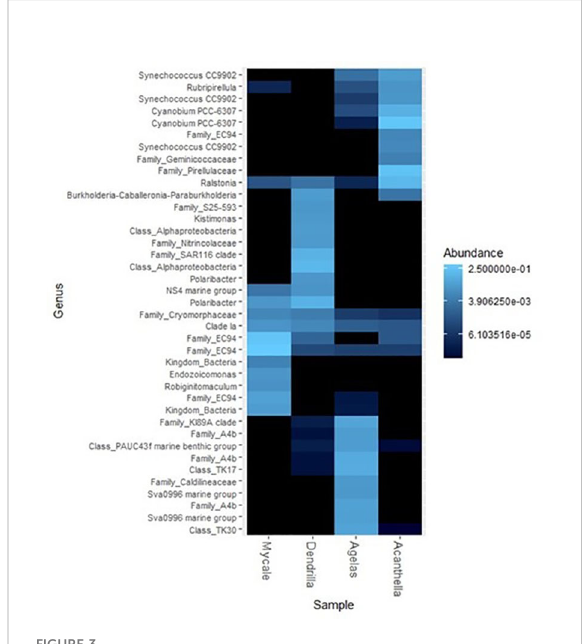
FIGURE 3 Heatmap representation of the abundance of the 10 most abundant ASVs of the different sponge species with its taxonomic af fi liation at the lowest taxonomic rank. Their presence in all sponge species is